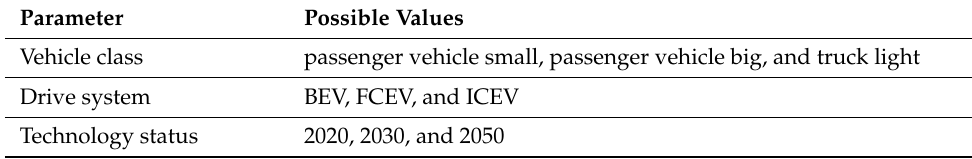
Table 13. Scenario parameters and their possible values used in current